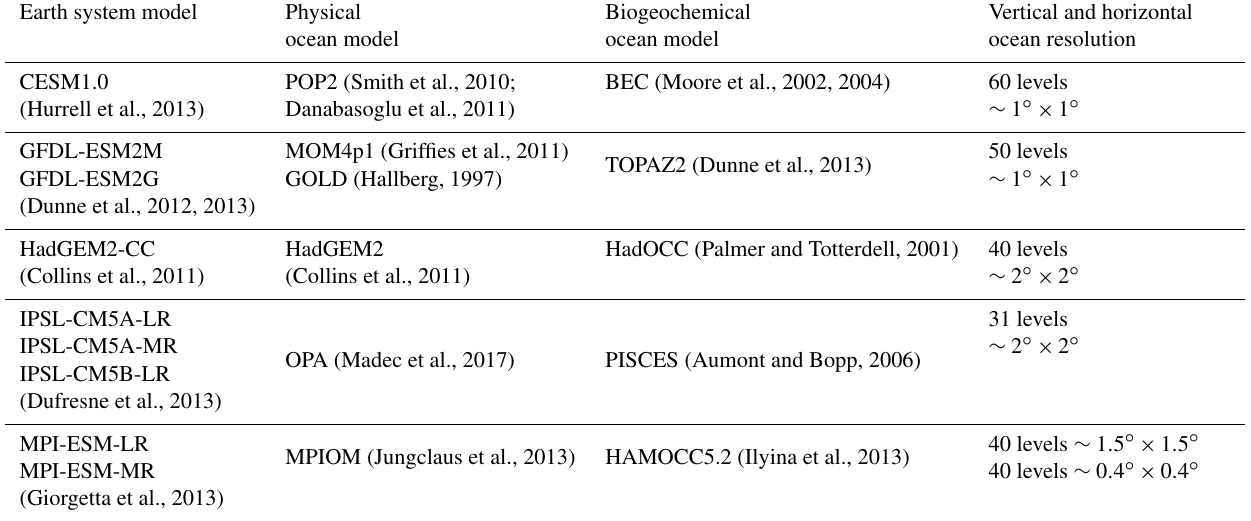
Table 1. Overview of the Earth system models used in this study, their configurations and vertical and approximated horizontal